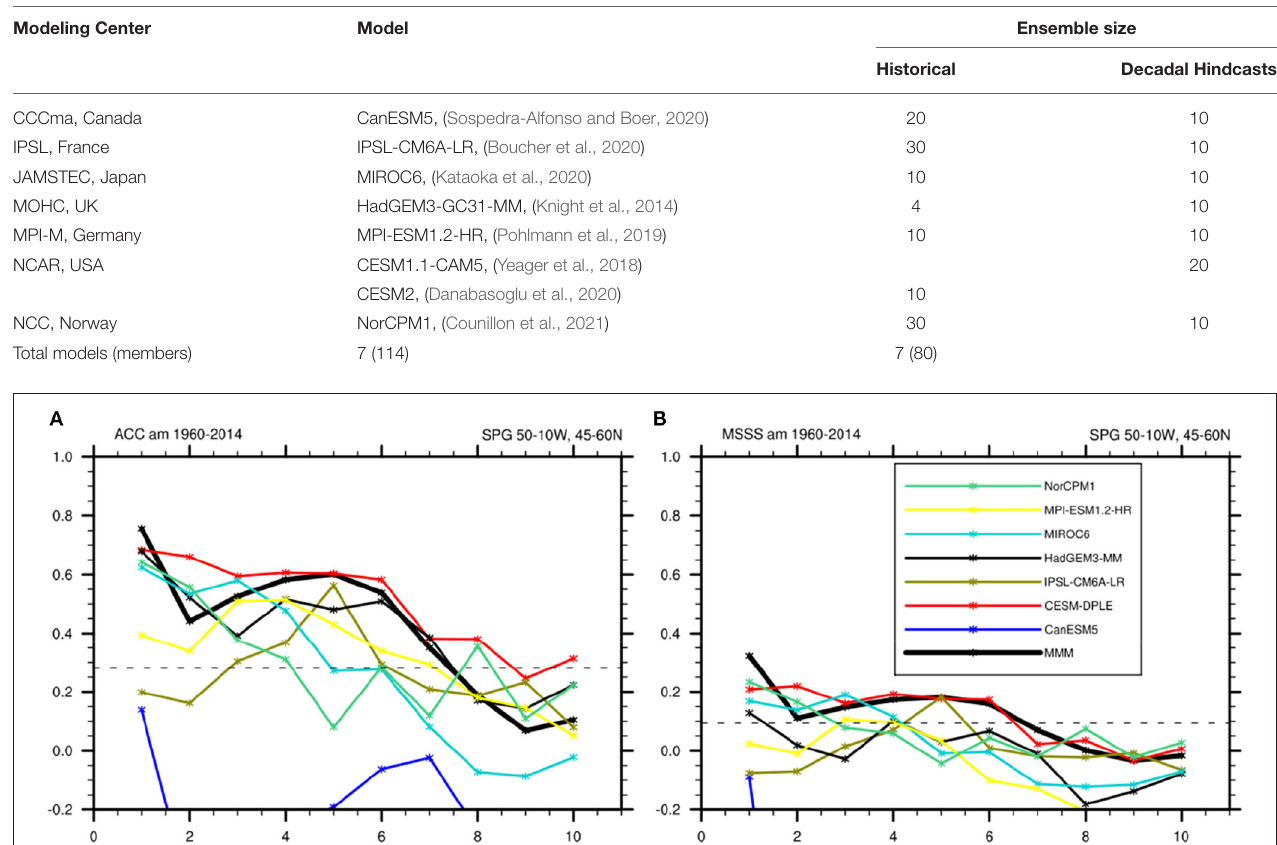
TABLE 2 | Models used in the analysis presented in Section Observational Constraints on Initialized Predictions, based on availability at the time of analysis. Modeling Center Model